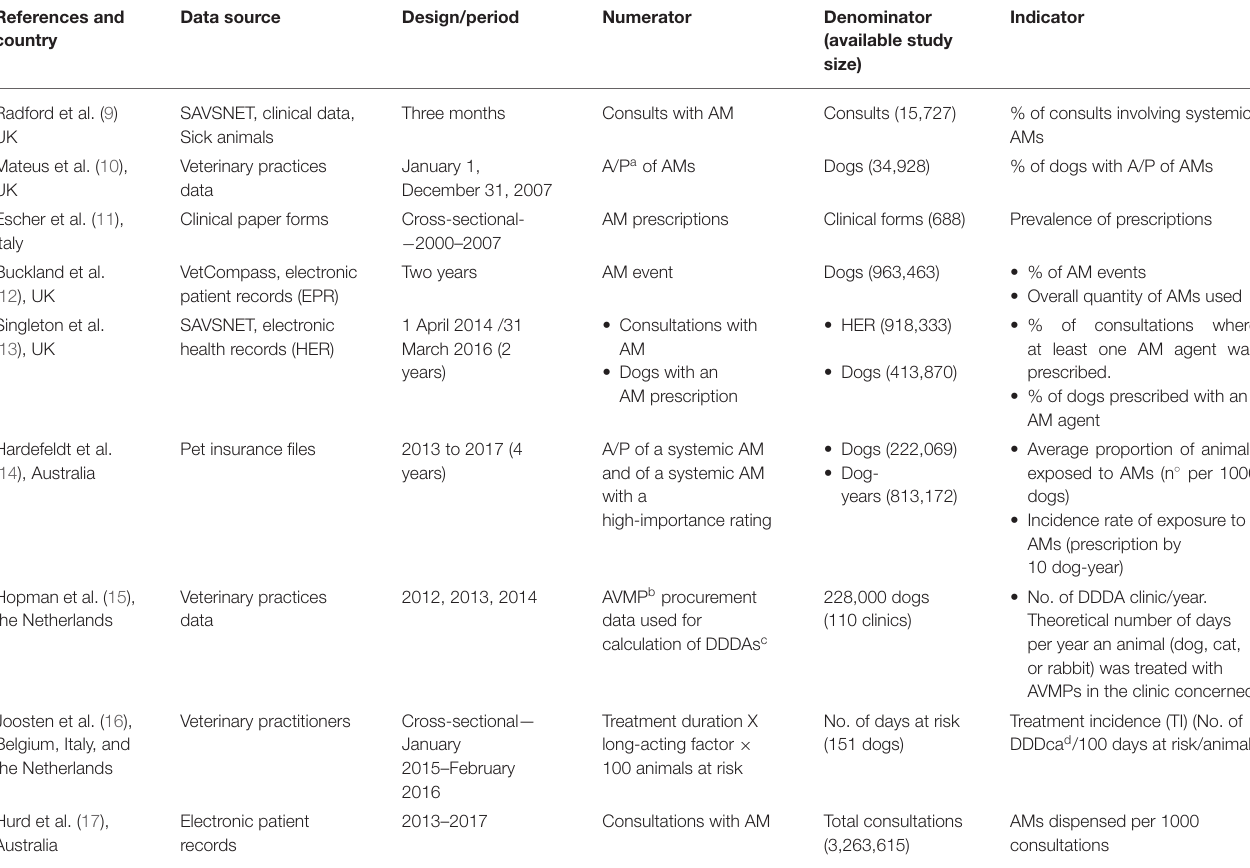
TABLE 1 | Published data of antimicrobial (AM) exposure in